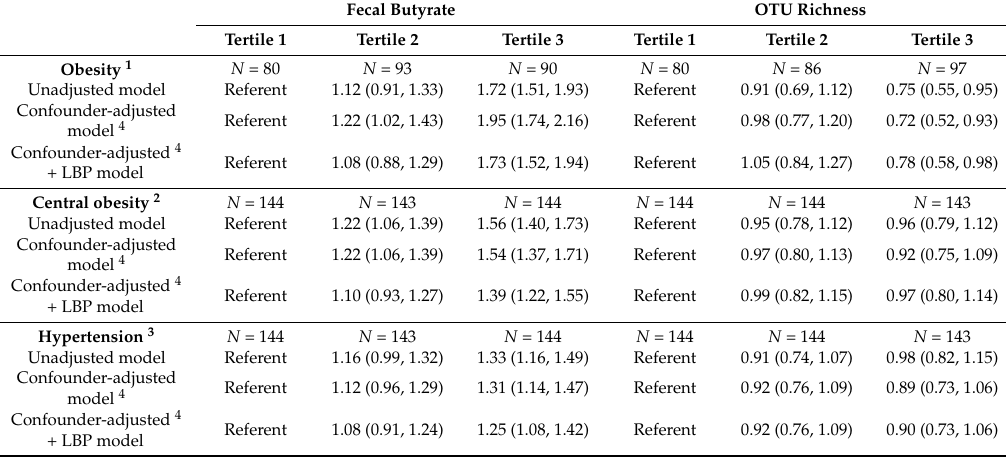
Table 3. Prevalence ratios of fecal butyrate concentrations and gut microbiota diversity for obesity, central obesity, and hypertension with robust 95% confidence intervals according to tertiles of fecal butyrate and OTU richness, a measures of gut microbiota